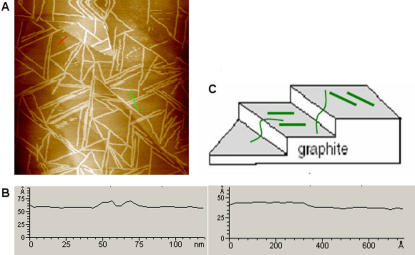
The preferred location of EAK16-II assembled nanofibers on the HOPG surface.(a) A representative AFM image of nanofibers on HOPG surface over a scan area of 800 nm×800 nm; (b) cross-sectional heights of nanofiber on one terrace (green line in a) and a step edge of HOPG (red line in a); (c) schematic diagram of nanofibers on HOPG surface.